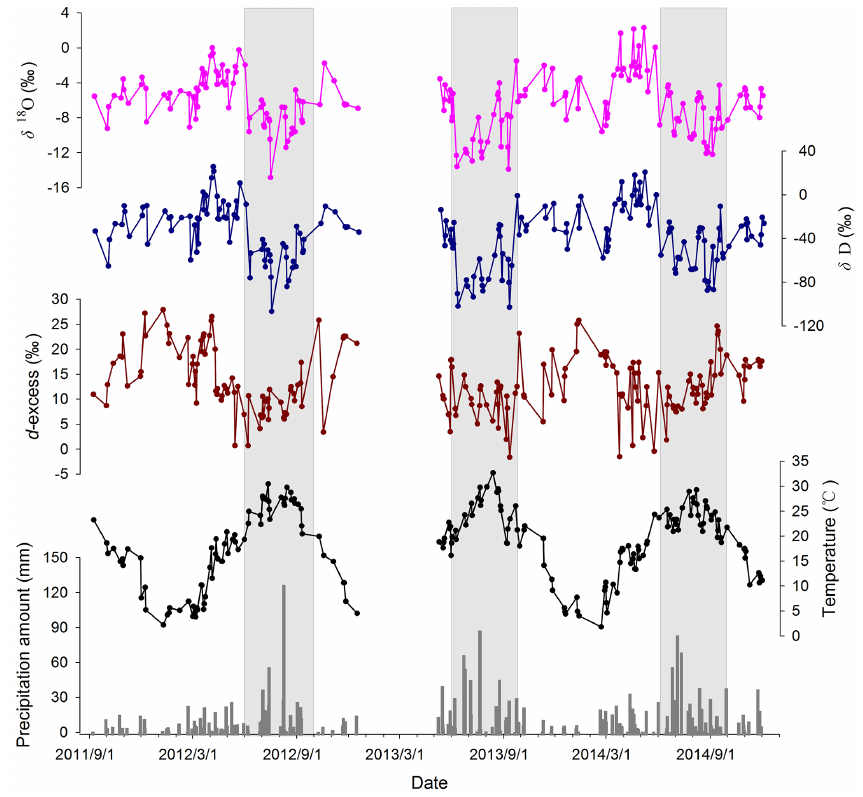
Figure 3. Temporal variations of daily precipitation δ 18 O, δ D, d-excess, surface air temperature and precipitation amount in Nanjing from September 2011 to November 2014. The shaded areas represent the summer monsoon seasons (June–September). Data is missing from January to April